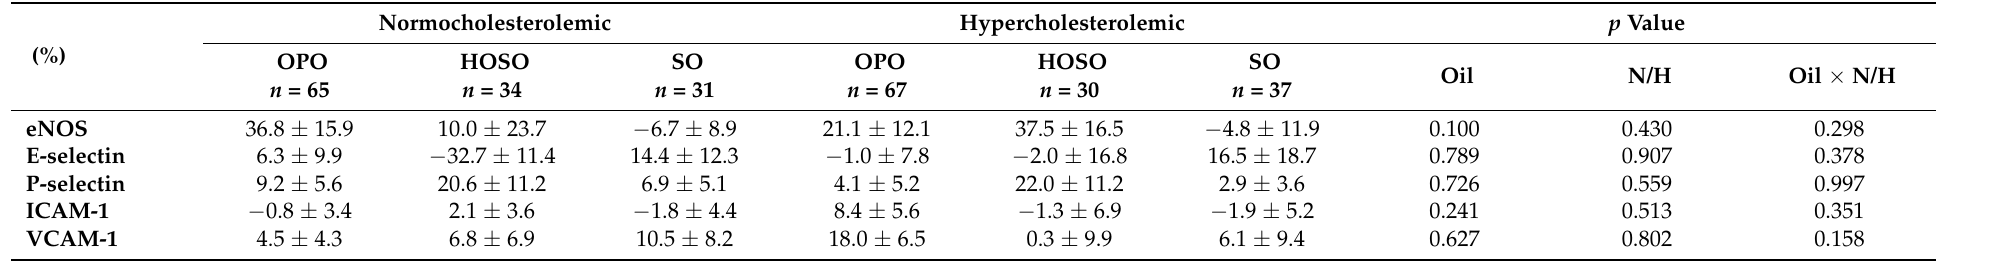
Table 3. Effects of olive pomace oil (OPO), high oleic sunflower oil (HOSO) and sunflower oil (SO) on endothelial function